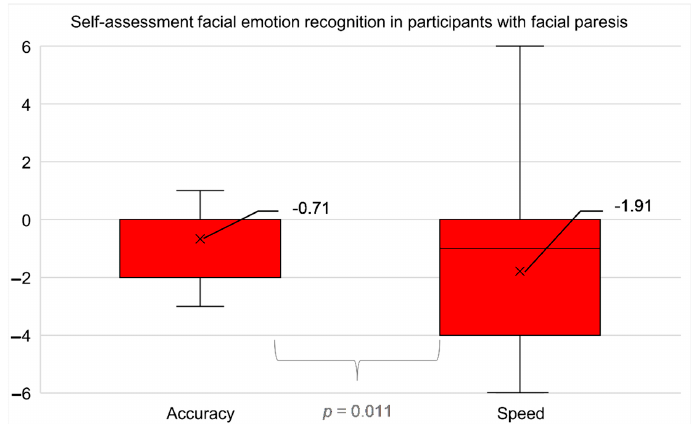
Figure 5. Accuracy and time taken in subjective facial emotion recognition (mean, median, inter- quartile range) in participants after stroke with facial paresis. Participants felt significantly more restricted in terms of time compared to accuracy ( p =